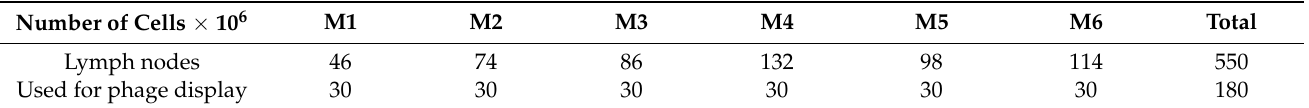
Figure 1. Sera LRRC15 specificity test. Sera of six mice were tested (1000 times diluted) on cells with no hLRRC15 expression (HeLa), recombinant hLRRC15 cells (HeLa hLRRC15), and cells constitutively expressing hLRRC15 (U87-MG, without TGFBeta induction). Mean value of LRRC15 labeling is given in %. The lymph nodes of each mouse were harvested, and immune cells were extracted by enzymatic digestion and then counted. The same quantities of 30 × 10 6 cells per mouse were picked and pooled. The mRNA extraction was completed on 180 × 10 6 cells from the pool (Table 1). Table 1. Lymph node cells obtained per